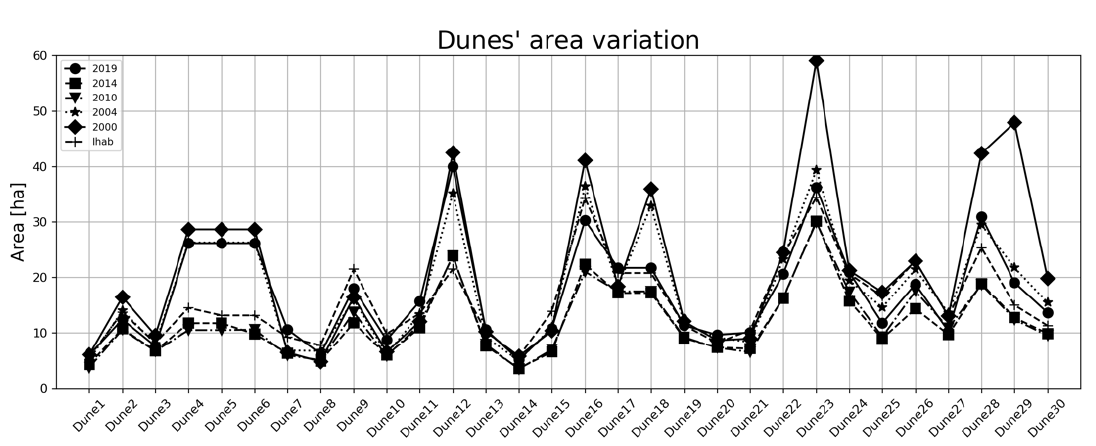
Figure 15. Dune area variation for the different years of the 30 dunes in common with [39]. Finally, our method provided dune migration information also for the dunes A, B and C, whose values are reported in Table 8. These values are not totally consistent with those found in the literature, probably due to the detected dune area being 85%, 80% and 65% of the area detected in the SAR images for dunes A, B and C, respectively. This underestimation of the dune area directly affects their centroid coordinates and hence the distance and velocity. Despite this, the values obtained are still in the range of the expected dune migration and close to the ground-truth values. Table 8. Dune information provided by the automatic method on SAR data acquired in 2004 and 2010 for the same dunes which were also manually delineated, located in the South Rayan dune field. Id.